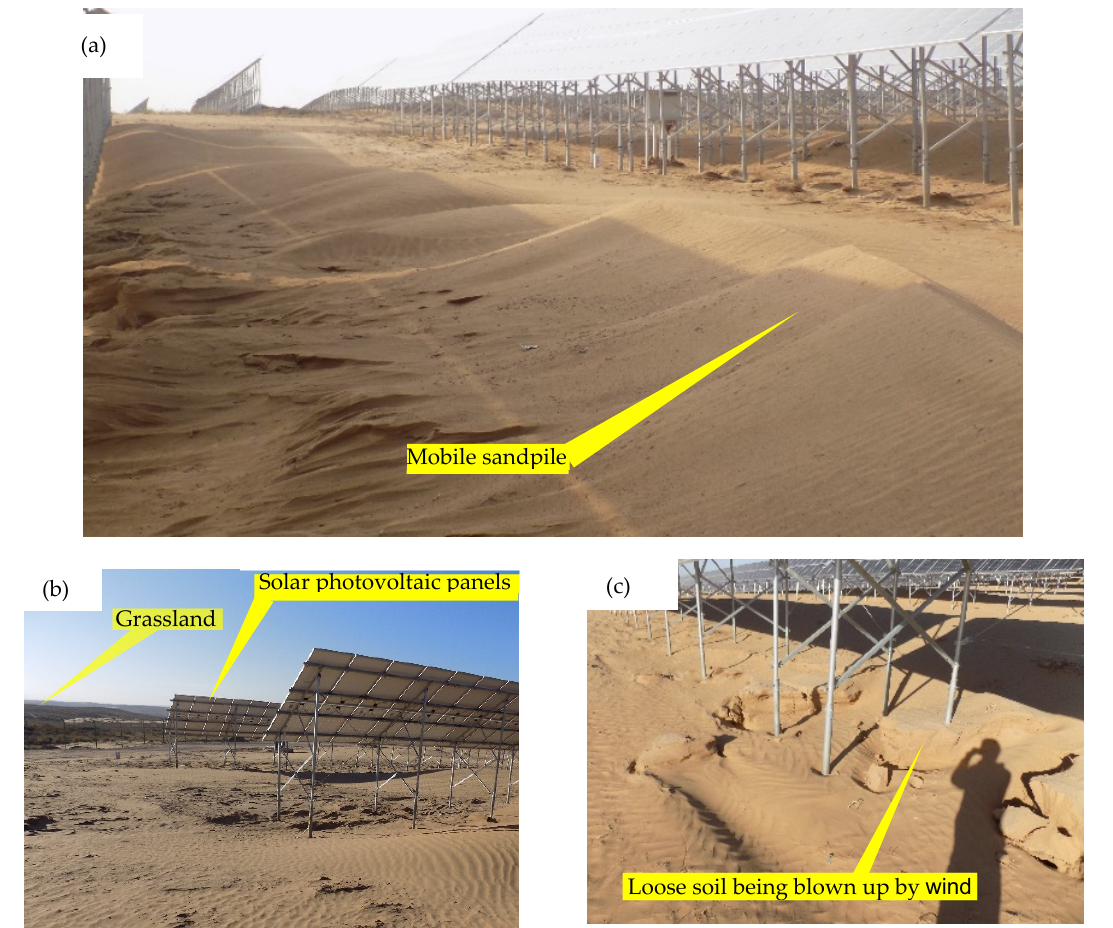
Figure 2. An onsite view of 25 October 2016, land desertification caused by the photovoltaic power generation project in Zhongning County, Ningxia Province. ( a ) Mobile dunes had been formed in the constructive area. ( b ) The land in the construction area was undergoing desertification, and the land outside the construction area was still grassland. ( c ) The soil around the support of the photovoltaic panel was blown away by the wind.